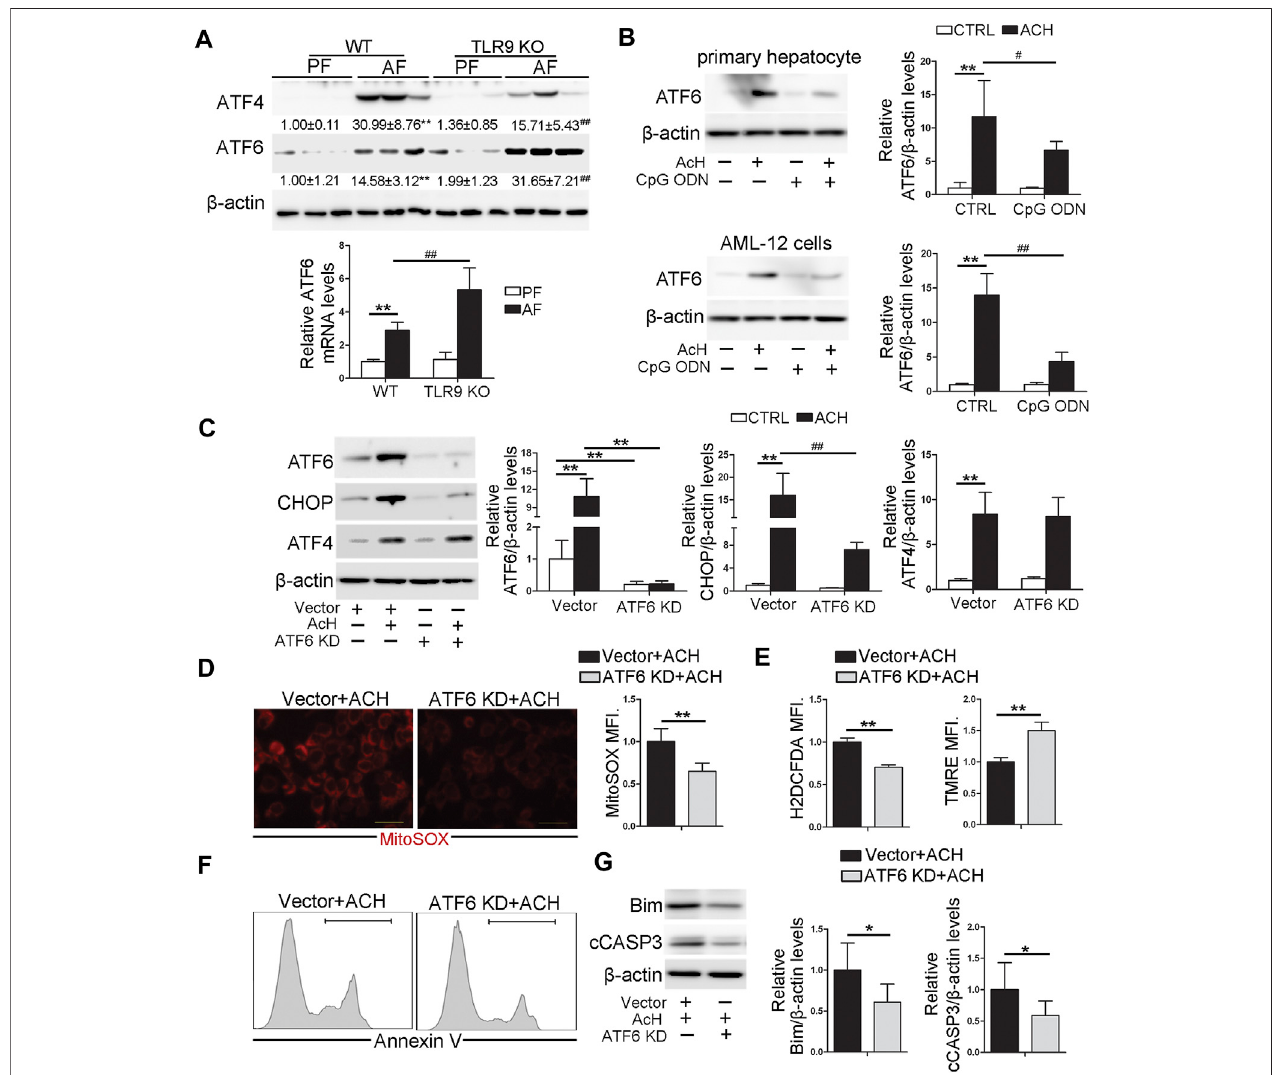
FIGURE6| TLR9controlCHOPactivationviaregulatingATF6inhepatocyte. (A) TLR9 KOandwild-typemalemicewerepair-fedoralcohol-fedfor8 weeksplusa single binge of ethanol (4 g/kg) before 4 h of tissue collection. Hepatic ATF4 and ATF6 protein levels and relative ATF6 mRNA levels in mice. (B) ATF6 protein levels in primary hepatocytes and AML12 cells. (C) Protein levels of ATF6, CHOP, and ATF4 in ATF6 knockout AML12 cells. (D) Immuno fl uorescent staining and fl ow cytometry analysisofmitochondrialROSusingMitoSOXprobe. (E) FACSanalysisofhepatictotalROSandmitochondrialmembranepotential. (F) FACSanalysisofapoptotic celldeathrepresented byAnnexinVpositivecells. (G) WesternblottingofBimand cCASP3. (A) ** p < 0.01vs. WT/PFmice; ## p < 0.01vs.WT/AFmice.PF, pair-fed;AF, alcohol-fed. (B,C) ** p < 0.01 vs. Control cells; # p < 0.05, ## p < 0.01 vs. ACH treated cells. (D – G) * < p 0.05, ** p < 0.01 vs. ACH treated cells.